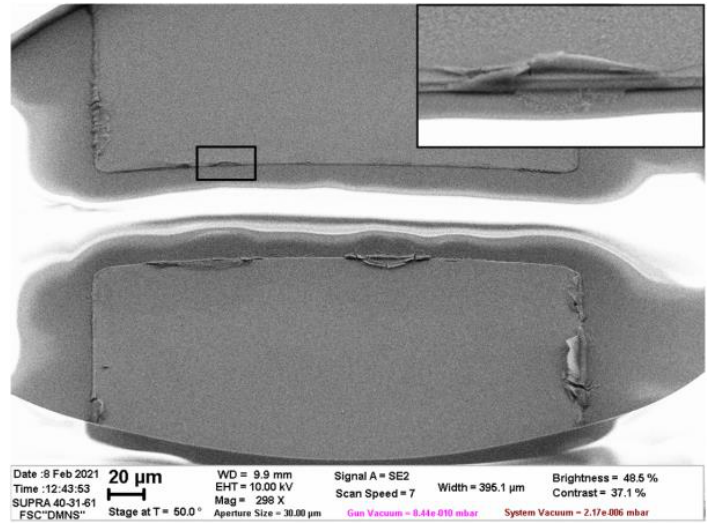
Figure 8. SEM image of the as-fabricated electrodes captured at an angle of 40° with respect to the substrate plane. The inset demonstrates the fence-like structure at the electrode edge, which is marked by the black frame.